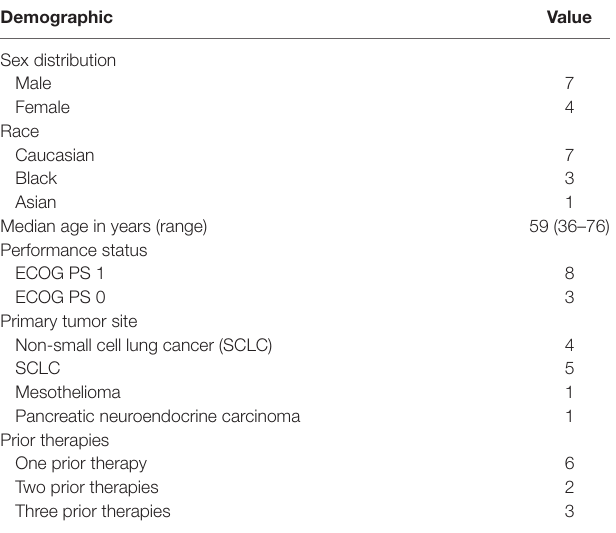
TablE 1 | Baseline demographics and patient